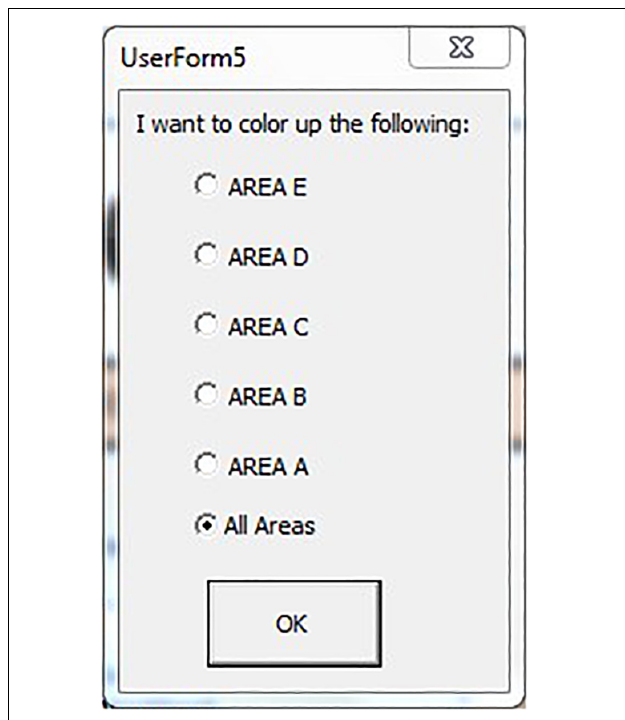
FIGURE 8 | LoSite window for area selection in step